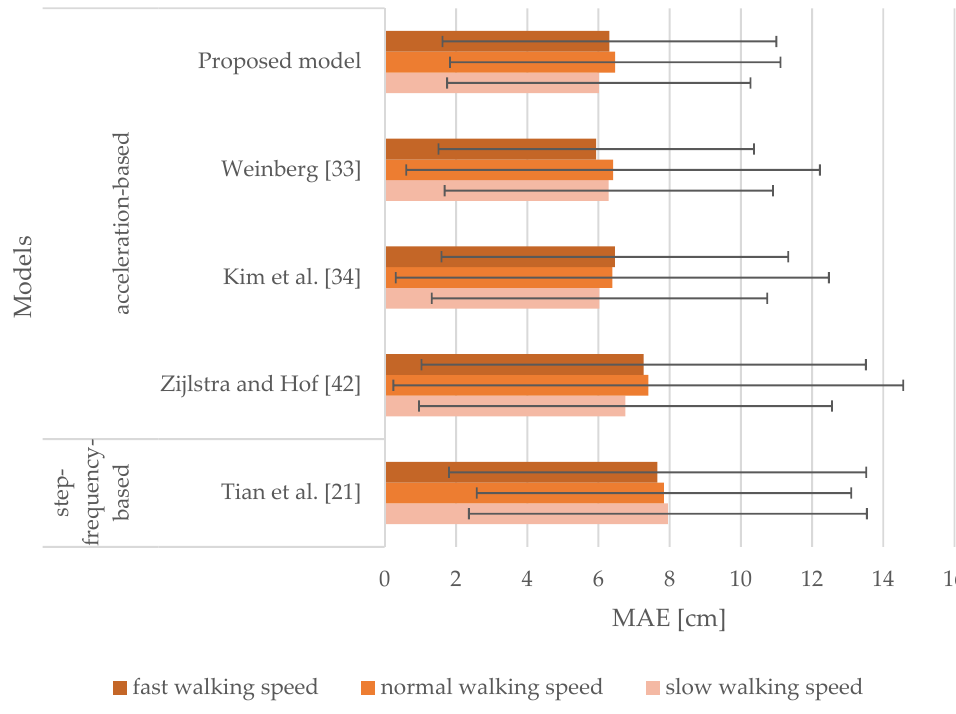
Figure 8. MAEs and SDs of the models for the smartphone attached to the pelvis for slow, normal, and fast walking speeds.